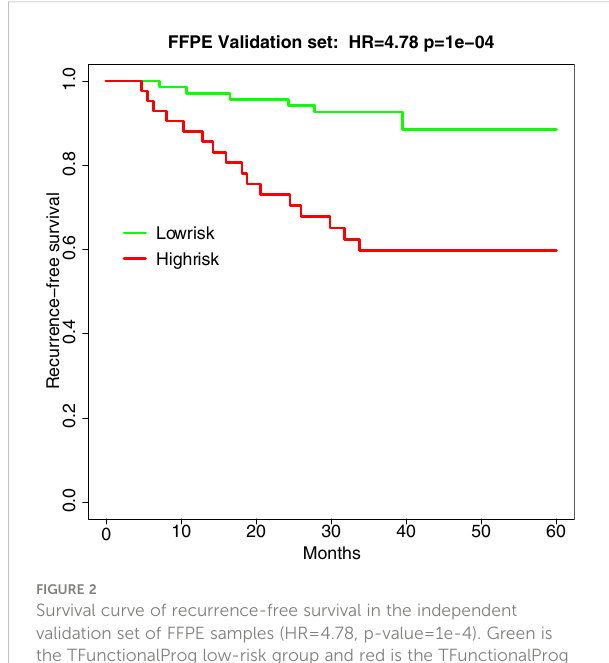
FFPE Validation set: HR=4.78 p=1e−04